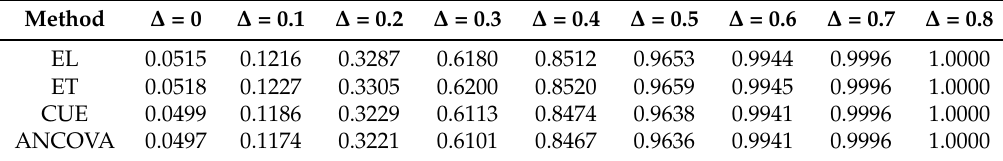
Table 8. Statistical power for ANCOVA and the GEL-based covariate adjustment methods. Method ∆ = 0